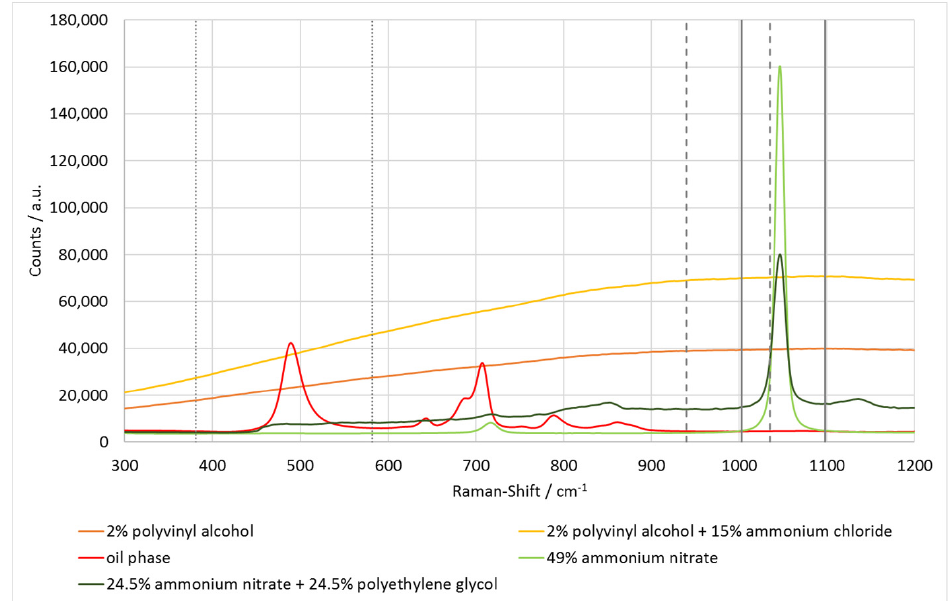
Figure 2. Section of the spectra of the individually measured phases of the double emulsions. In addition, the limits of the bandpass filters used are shown: dotted lines - oil phase; dashed lines - addition, the limits of the bandpass filters used are shown: dotted lines—oil phase; dashed lines— reference; solid lines - ammonium nitrate and inner water phase, respectively. reference; solid lines—ammonium nitrate and inner water phase,